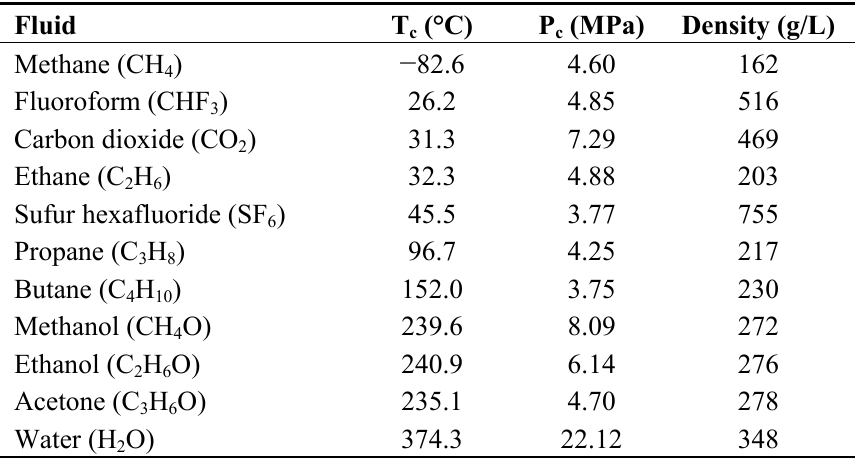
Table 1. Fluids used in near-critical or supercritical conditions for (bio)catalysis and their critical parameters